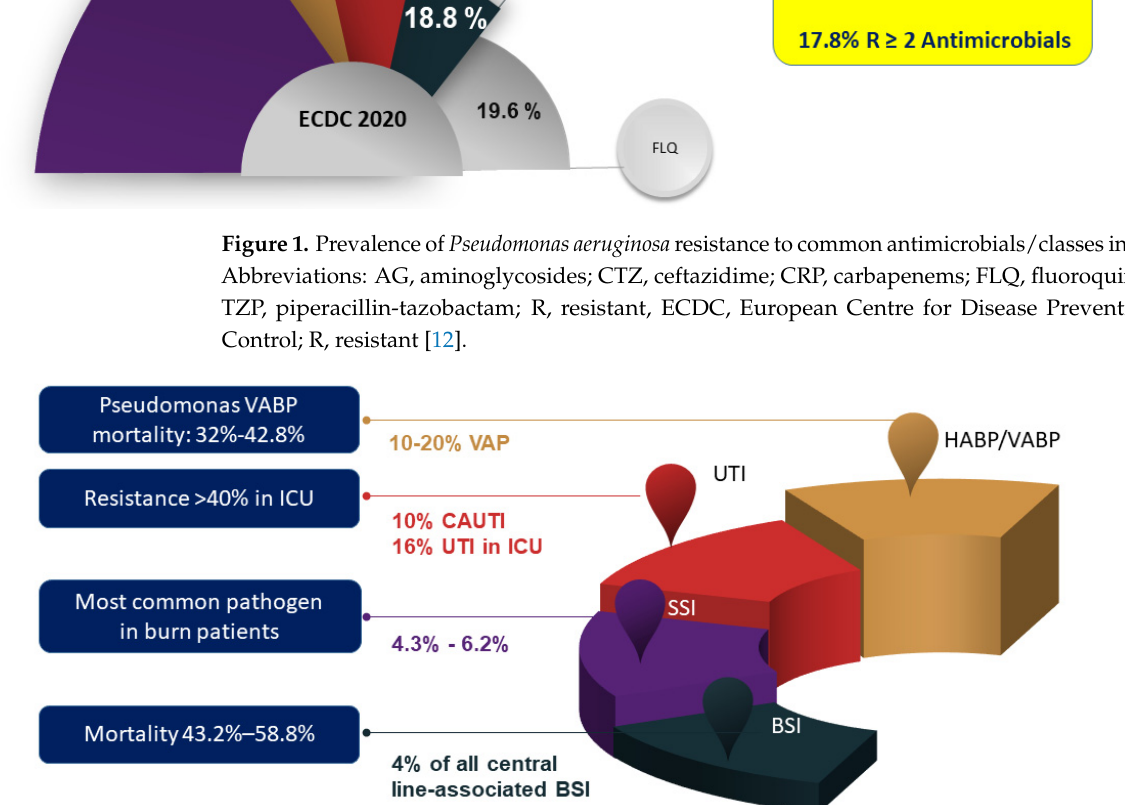
Figure 1. Prevalence of Pseudomonas aeruginosa resistance to common antimicrobials/classes in Europe. Abbreviations: AG, aminoglycosides; CTZ, ceftazidime; CRP, carbapenems; FLQ, fluoroquinolones; TZP, piperacillin-tazobactam; R, resistant, ECDC, European Centre for Disease Prevention and Control; R, resistant [12].